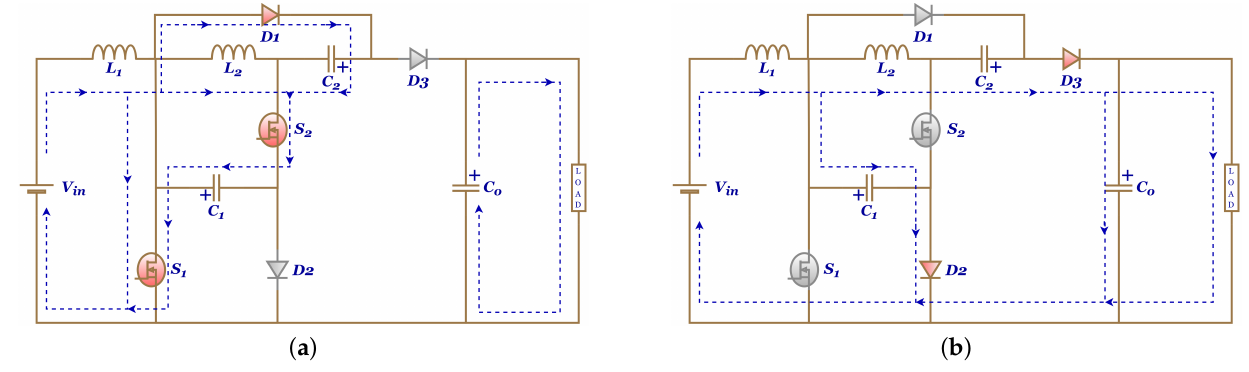
Figure 20. 4th M-PSOL operation: ( a ) S 1 and S 2 closed, and ( b ) S 1 and S 2